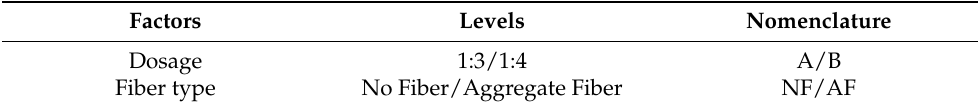
Table 6. Factors and levels used for the analysis of variance